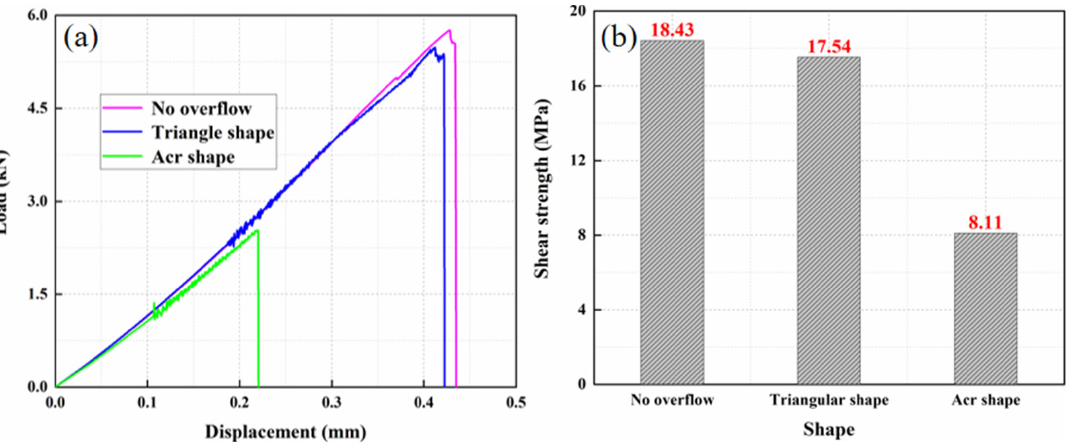
Figure 11. The result of different adhesive layer shapes: ( a ) load displacement curve and ( b ) shear strength.